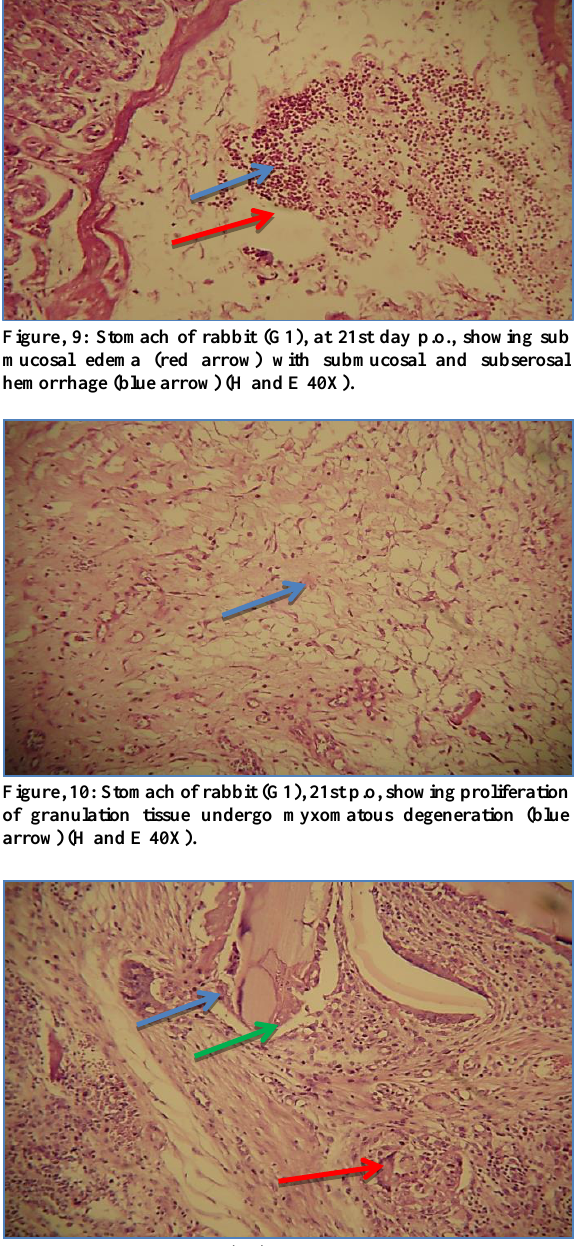
Figure, 11: Stomach in (G1), 21st p.o, showed foreign body granulomas containing the remnant of suture materials (blue arrow) surrounded by large numbers of epithelioid cells (green arrow) with giant cells formation (red arrow) ( H and E 40X).